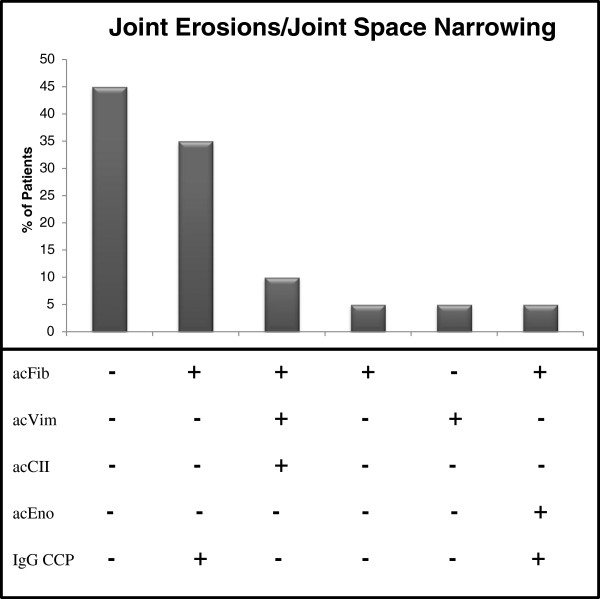
Percentage of JIA patients with radiographic progression (n=20) based on their anti-citrullinated antibody profile. acCII: anti-citrullinated type II collagen antibodies; acEno: anti-citrullinated α-enolase antibodies; acFib: anti-citrullinated fibrinogen antibodies; acVim: anti-citrullinated vimentin (aa1-16 and aa59-74) antibodies; CCP: cyclic citrullinated peptide.